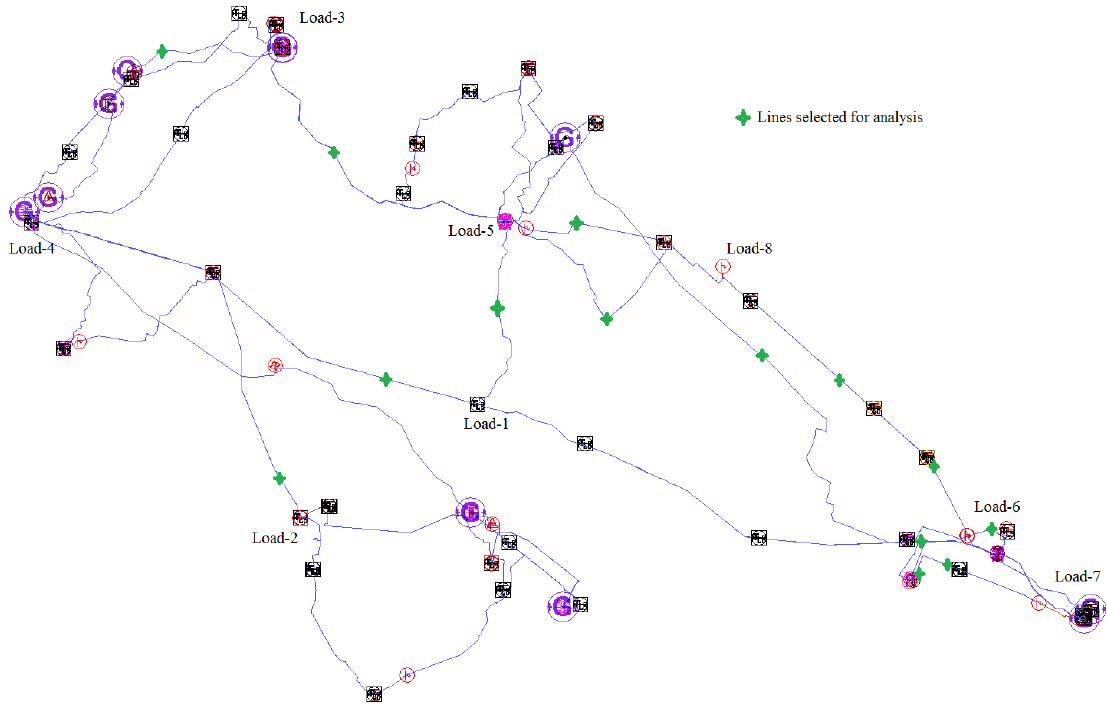
Figure 5. Example system model with load locations marked as Load-1 through Load-8 for localized loading analysis in Case Study 2. Lines with least stability margins, as identified in Section 3.2.2 and used in Section 3.2.3, are marked with green plus symbols.